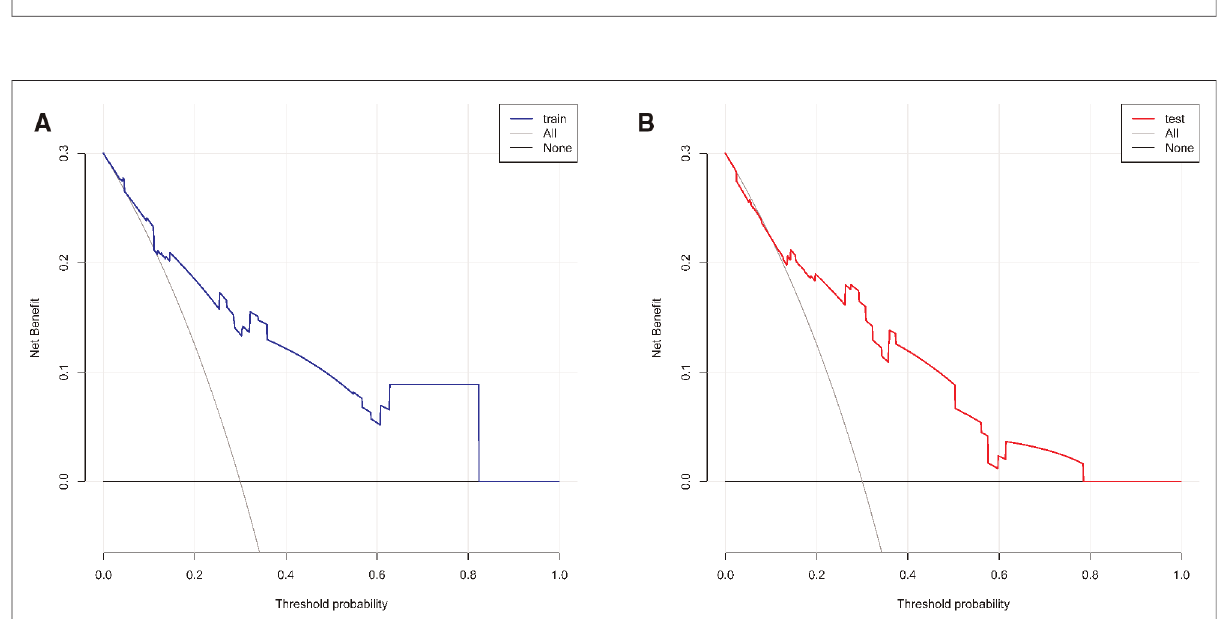
FIGURE 3 The calibration curve of the nomogram for predicting upper urinary tract damage in the training and testing datasets. ( A ) Training cohort. ( B ) Validation cohort.